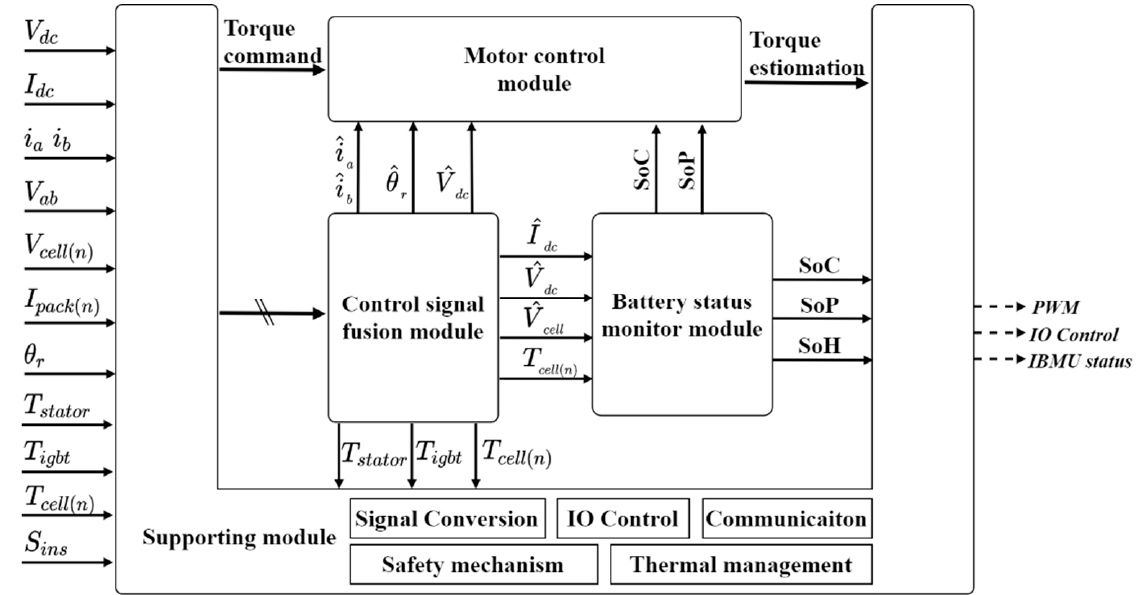
Figure 3. Proposed IBMU algorithm architecture.